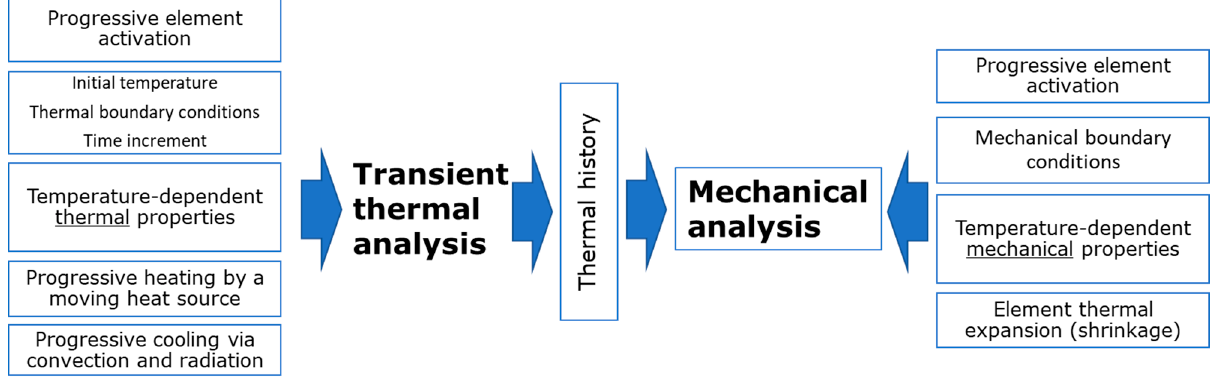
Figure 6. Scheme of thermomechanical simulation of SLM process.